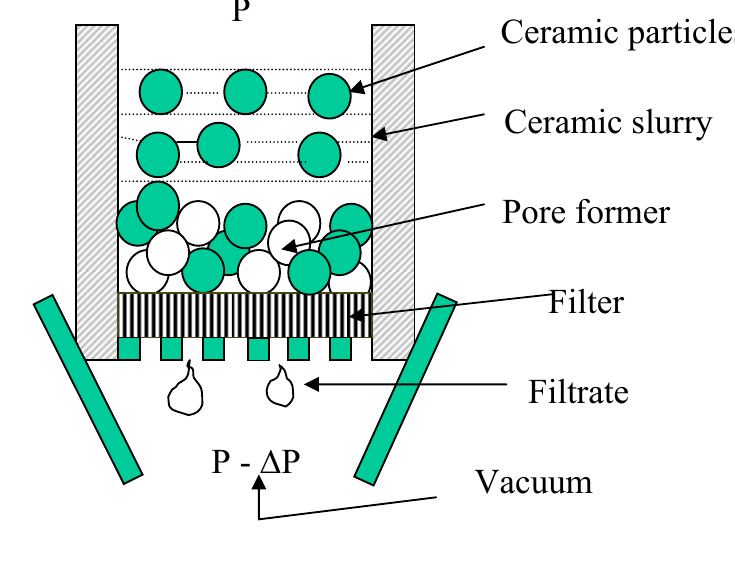
Figure 6. Schematic illustration showing the formation of a green compact among the pore space within the polymer bead bed (P: pressure drop; ∆ P: pressure